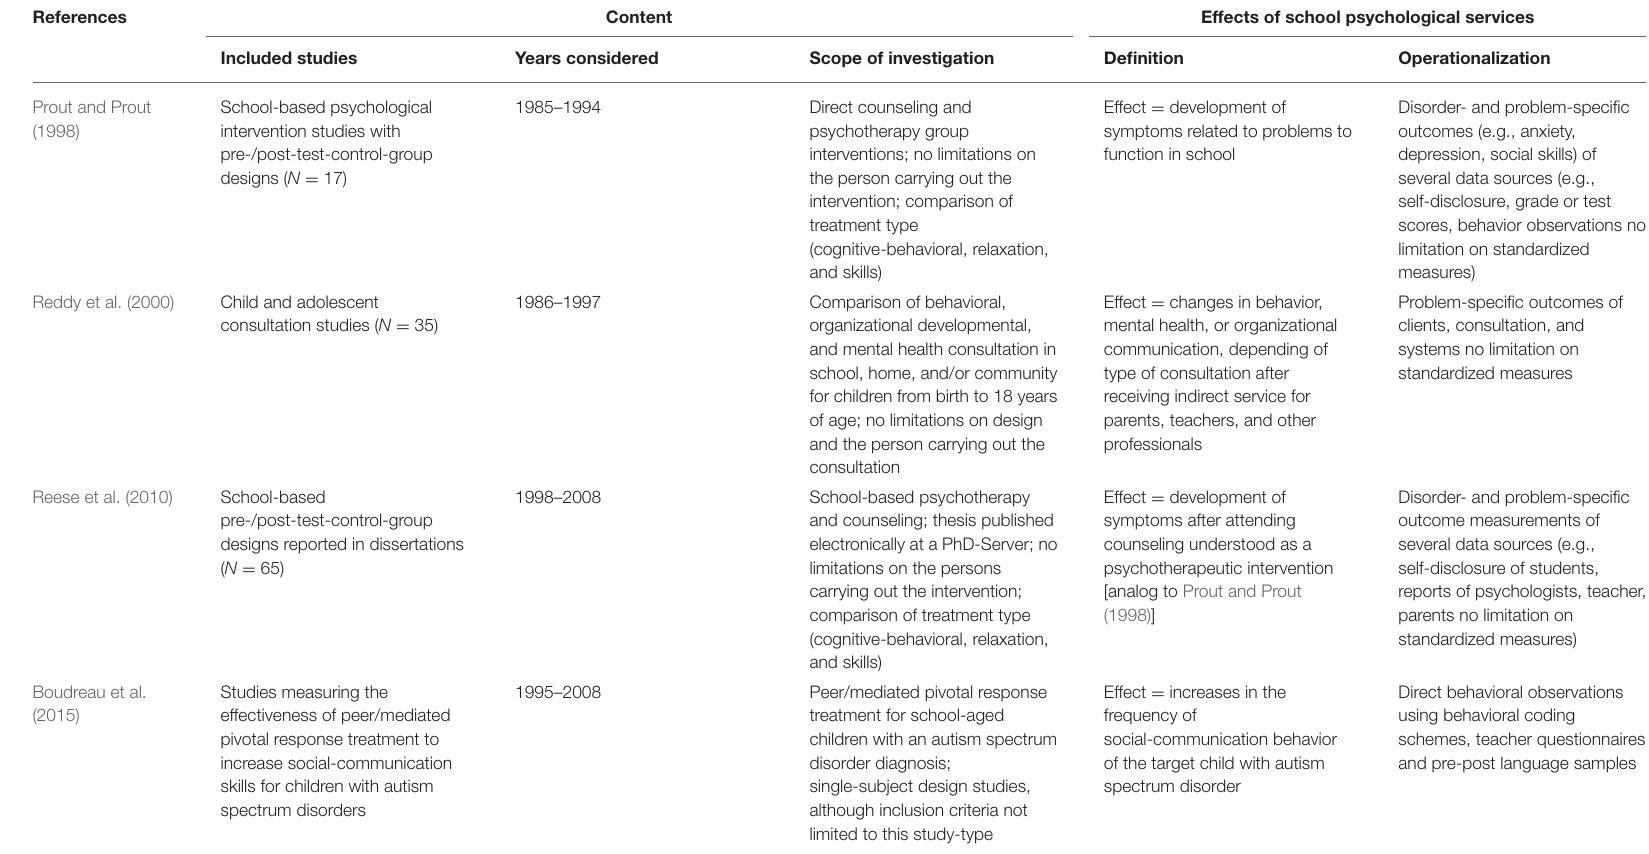
TABLE 3C | Summary of included